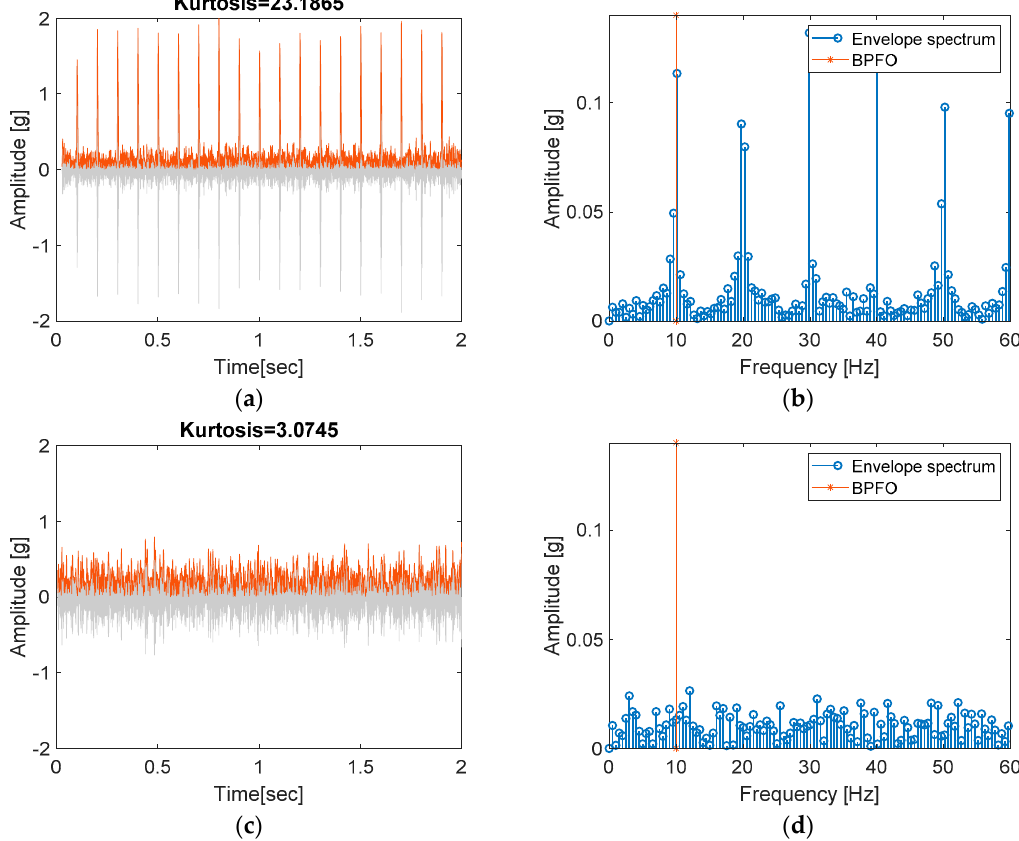
Figure 11. Result of envelope analysis: envelope signal in ( a ) time domain ( b ) frequency domain of faulty bearing, in ( c ) time domain and ( d ) frequency domain of normal bearing.